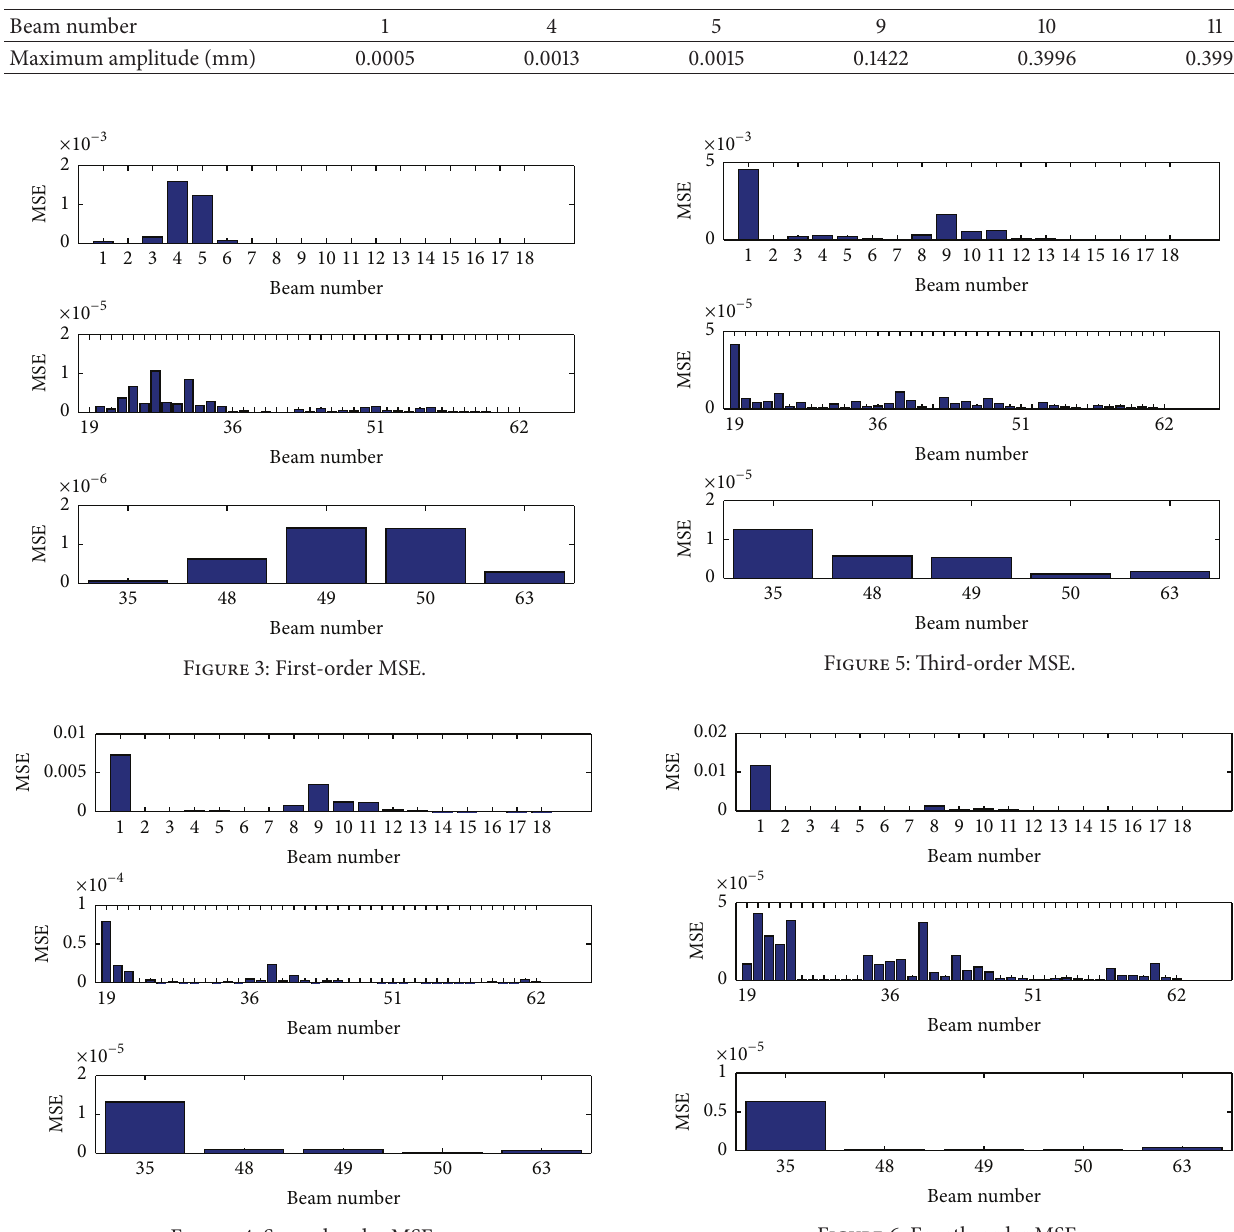
Figure 4: Second-order MSE.